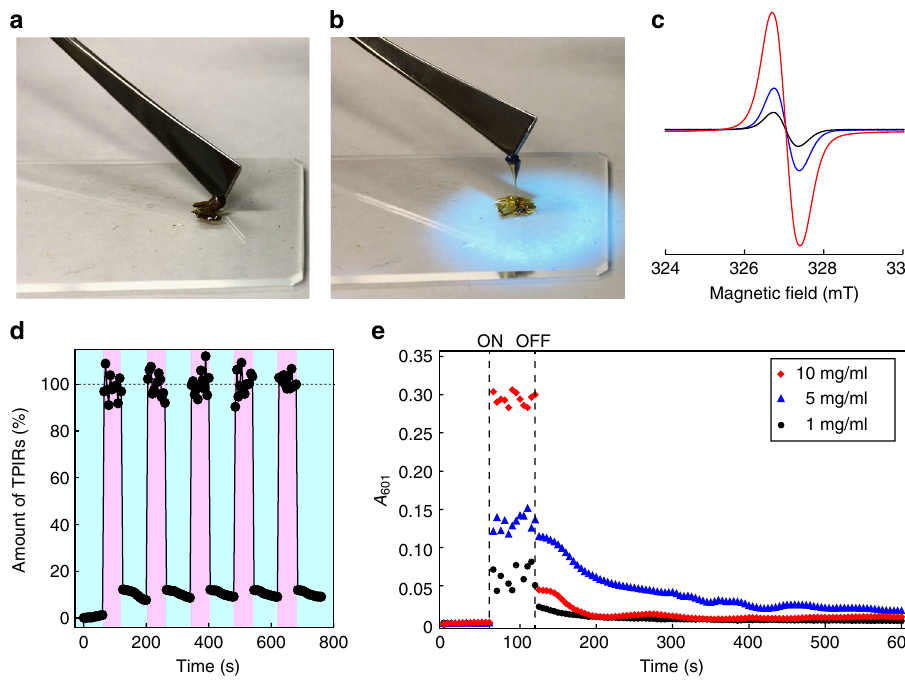
Fig. 2 IRLNC experiment with network-PBA HABI network-PBA HABI . Photographs of network-PBA HABI a before and b after UV irradiation. c ESR spectra of network-PBA HABI before ( black ) and during ( red ) UV irradiation for 1 min, and 1 min after terminating UV irradiation ( blue ). d Time-dependent plots of the amounts of TPIR in a THF solution of network-PBA HABI (10 mg/ml). The amount of TPIR was determined by recording A 601 every 5 s. The sample was irradiated with UV and not irradiated with UV during times corresponding to the pink and light blue regions , respectively. The value of A 601 before UV irradiation was de fi ned as 0% and the averaged A 601 during UV irradiation was de fi ned as 100%. e Time-dependent plots of absorbance at 601 nm for network-PBA HABI in THF. Initial network-PBA HABI concentration was 1 mg/ml ( black circle ), 5 mg/ml (blue triangle ), and 10 mg/ml ( red diamond ), respectively. The starting (ON) and terminating (OFF) times of UV irradiation were indicated with dashed